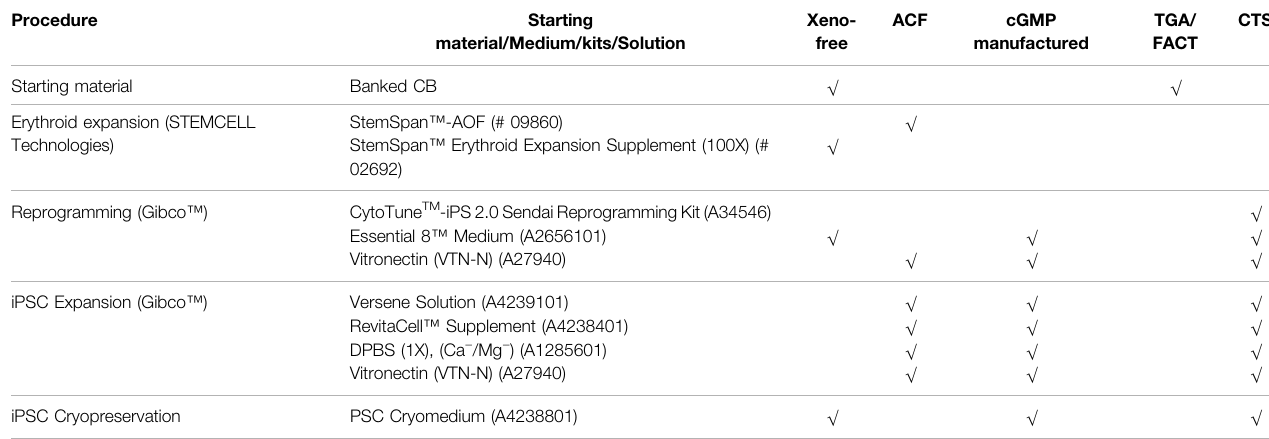
TABLE 1 | The composition of chemically de fi ned and xeno-free materials for hiPSC generation. Materials include the starting material, reprogramming kit, buffers and solutions used in the iPSC generation. Xeno-free: non-human-derived components; ACF: animal component-free; TGA: Therapeutic Goods Administration; FACT: Foundation for the Accreditation of Cellular Therapy; CTS: Cell Therapy Systems https://www.thermo fi sher.com/au/en/home/clinical/cell-gene-therapy/cell-therapy/cell- therapy-systems.html?SID=fr-ctsystems-main. Products in the CTS column allow researchers to move their cell products from bench to clinical trial. Procedure Starting